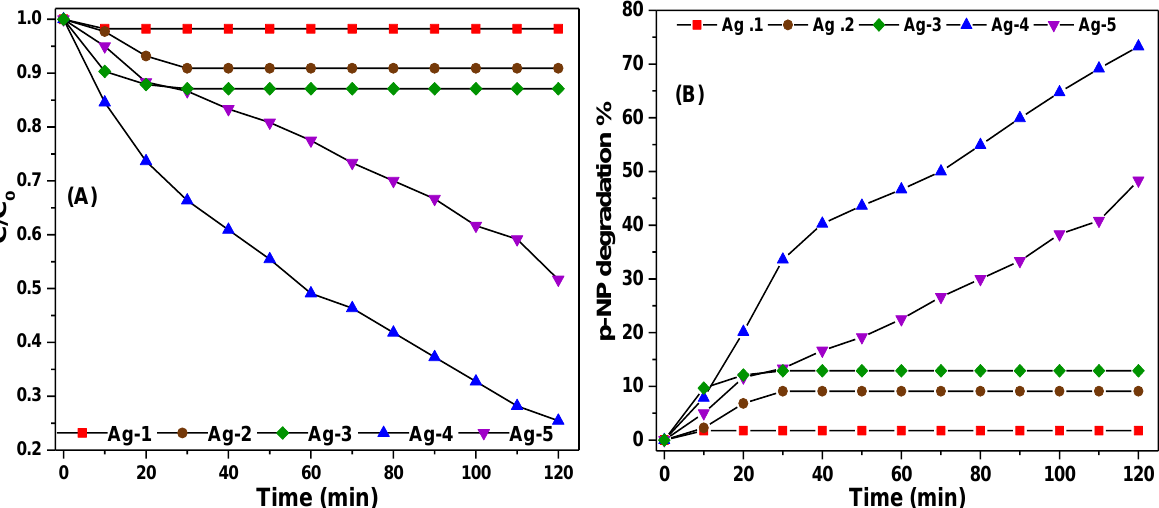
Figure 8. ( A ) Photocatalytic efficiency ( B ) percentage degradation of p -NP over synthesized Ag nanomaterials under visible light.